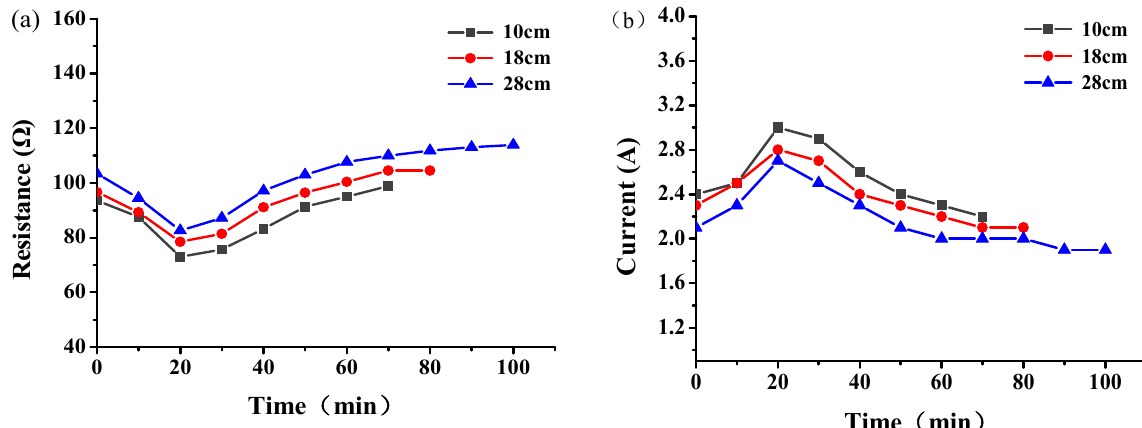
Figure 7. Resistance ( a ) and current ( b ) of graphene composite conductive concrete slabs with different electrode spacings.